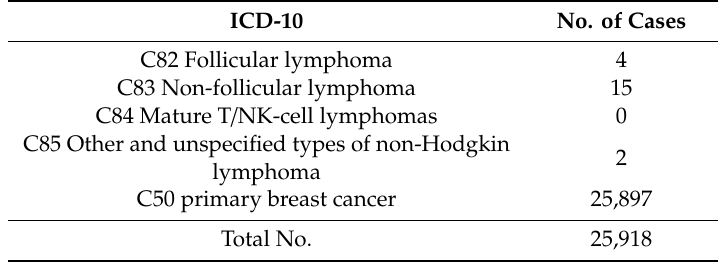
ICD-10 = 10th revision of international classification of diseases; No. =